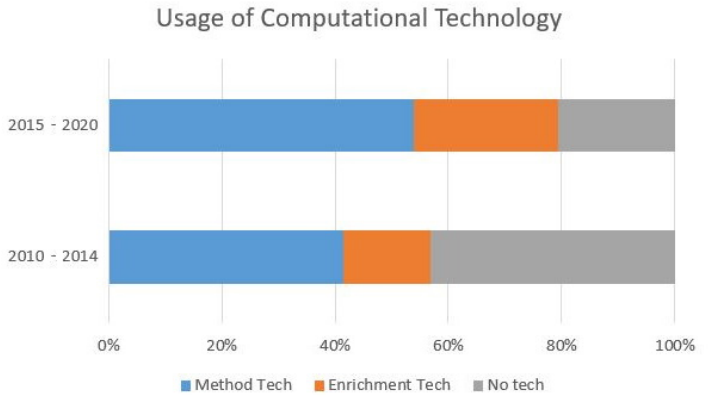
Figure 3. Utilization of technology in enrichment studies between the first and second half of the 2010